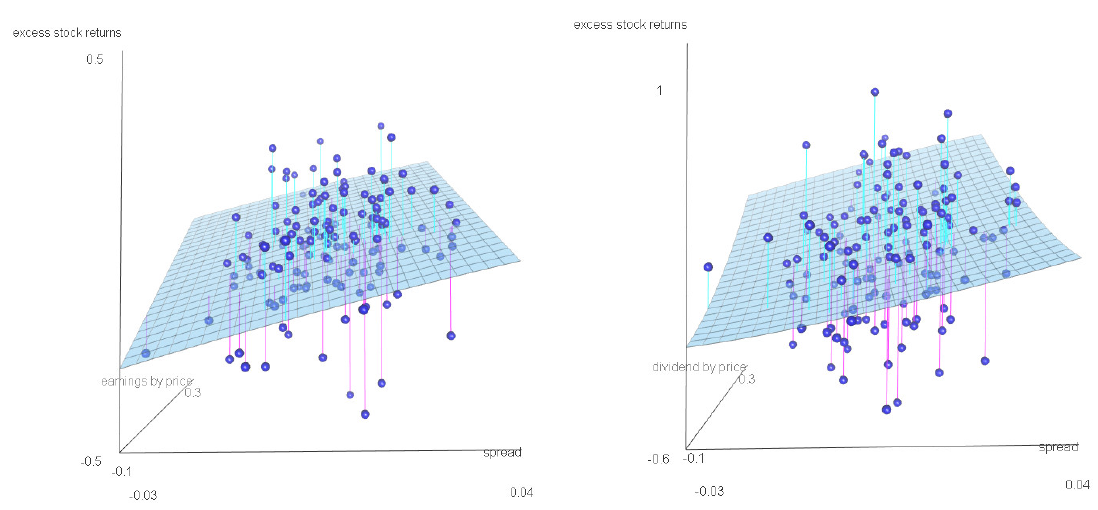
Figure 3. Inflation benchmark. Relation between excess stock returns and predictive variables: the earnings-by-price ratio and the spread, one-year horizon ( left ); the earnings-by-price ratio and the spread, five-year horizon ( right ). Estimated nonparametric function ˆ m (light blue surface) and observations (dark blue balls). Period: 1872-2020. Data: annual S&P